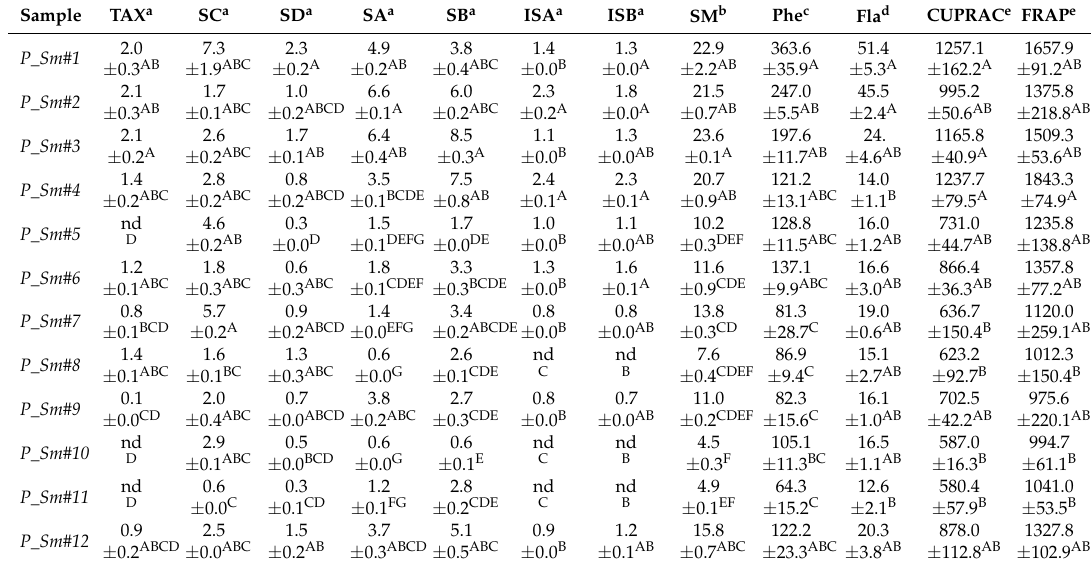
Table 5. Content of silymarin constituents, total phenolics, total flavonoids, and antioxidant capacity of different genotypes of milk thistle from